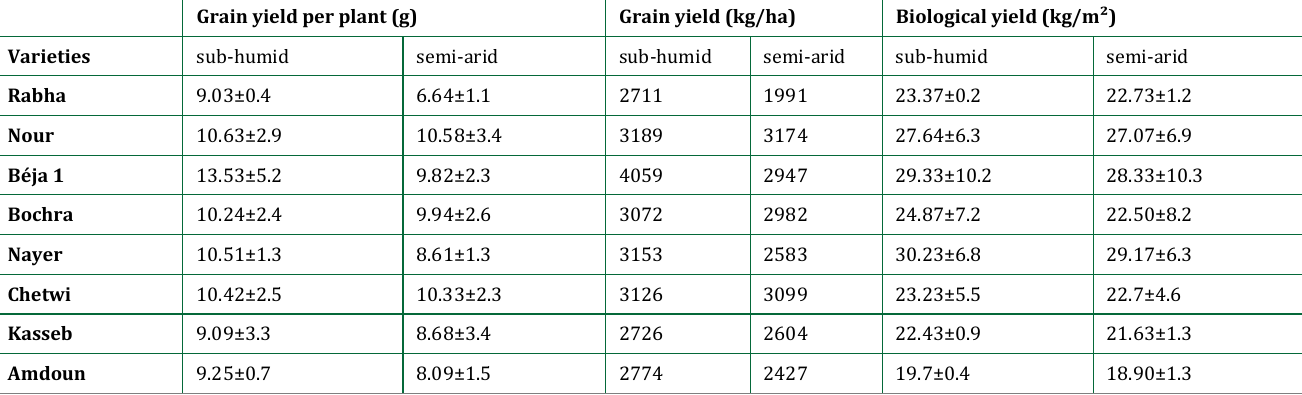
Table 3: Mean values of grain yield and biological yield as a function of the interaction’s cultivar × bioclimatic stage Grain yield per plant (g)